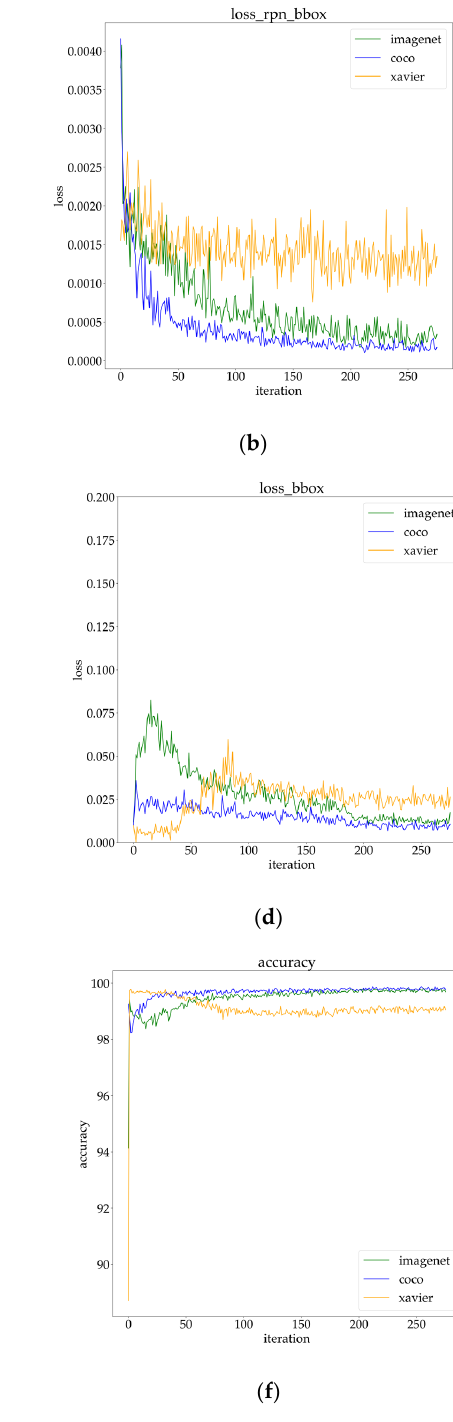
Figure 8. The visualization of training: ( a ) classification loss in RPN; ( b ) localization loss in RPN; ( c ) classification loss; ( d ) localization loss in bounding box regression; ( e ) total loss; ( f ) accuracy.